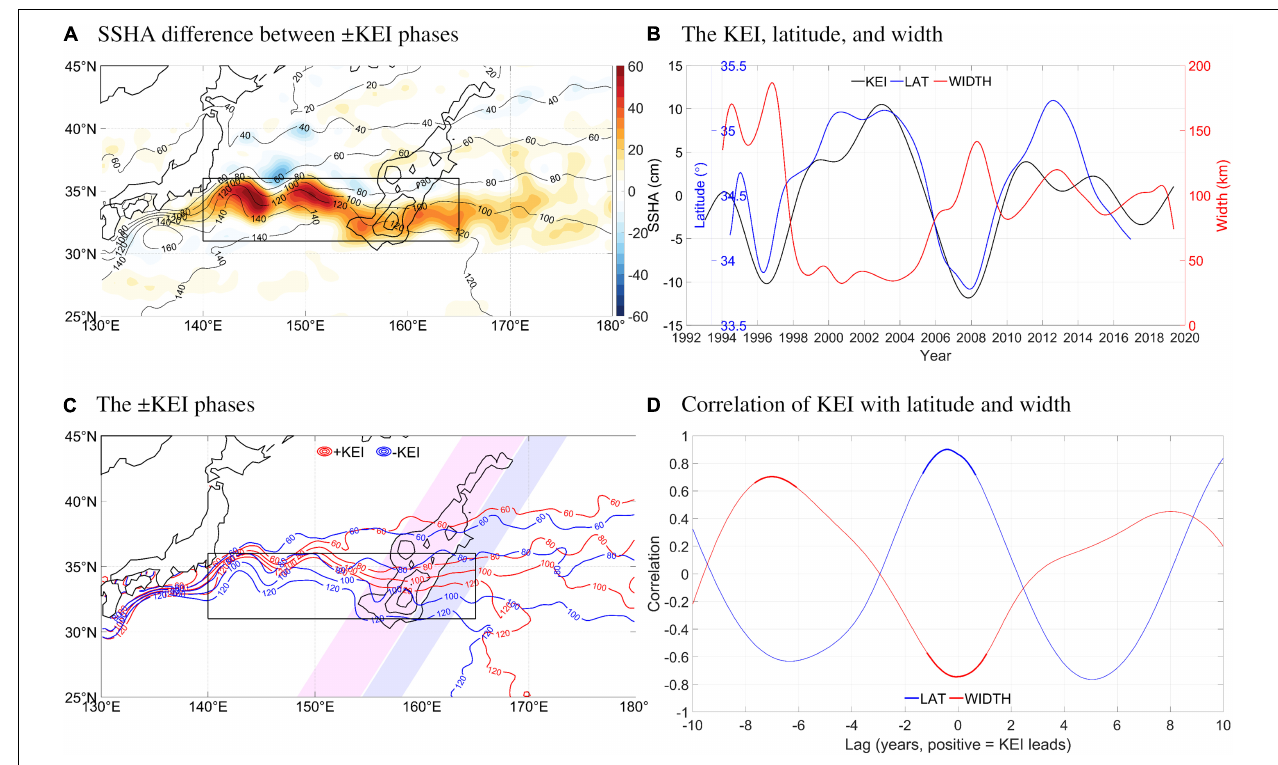
FIGURE 1 | (A) Time-mean SSH (thin contours; cm) and bathymetry of the Shatsky Rise (thick contours; CI = 1 km starting from 5 km). Shading shows the SSHA difference (cm) between the ± KEI phases. (B) Time series of the KEI (black), latitude of the 100 cm SSH contour (142–160 ◦ E; blue), and meridional width between 90 and 110 cm SSH contours (red). (C) SSH (thin contours; cm) of the ± KEI phases. The Shatsky Rise is shown with thick contours as in (A) . The magenta and blue patches will be used later in Figure 5 . (D) Correlation between the KEI and the latitude and width indices. Thick curves denote statistical significance at the 95% level. The effective degrees of freedom are 2.6–4.4 (LAT) and 4.8–7.9 (WIDTH) depending on the